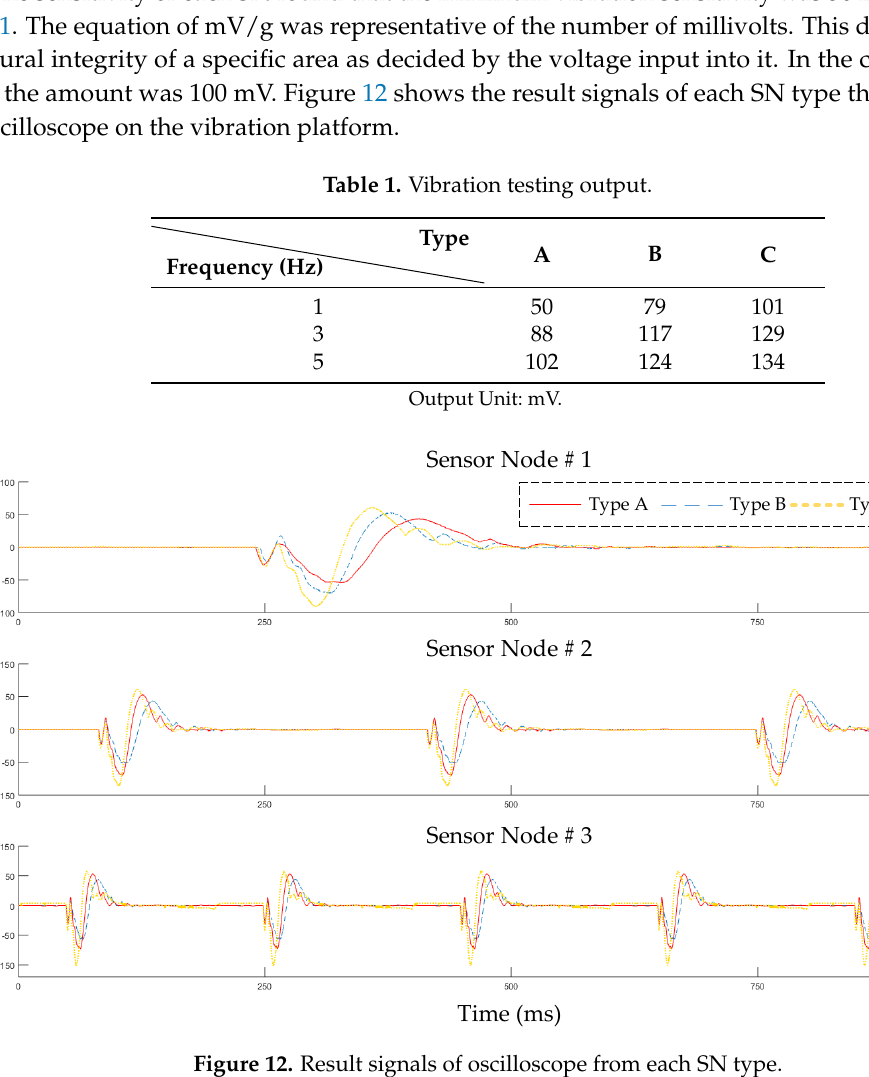
Table 2. Data Transmission in WMN of experiment